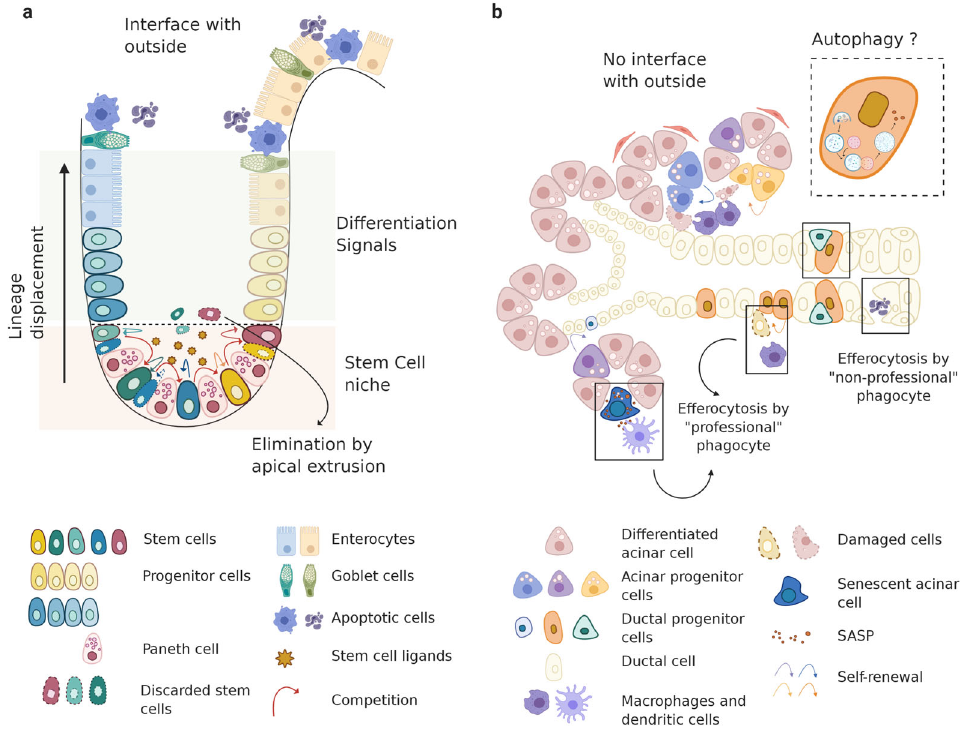
Fig. 3 Tissue anatomy and niche size determine the regenerative strategy adopted by different tissues. Adult stem cells in fast turnover epithelial tissues, such as the intestine ( a ), are subjected to neutral competition for limited stem cell-promoting factors and niche space. Only cells that have the capacity to receive stem cell-promoting factors will remain stem cells, the others will be eliminated by extrusion from the niche or via lineage displacement in the outer space. In a slow turnover tissue, such as the salivary gland ( b ), the high cellular density, as well as the branching structure, of the tissue could explain the absence of a “ professional ” stem-like cell and explain instead the presence of lineage-restricted progenitors. The absence of a direct opening for disposal of damaged/unwanted cells could force salivary glands to use alternative slower clearance routes, such as autophagy or tissue-resident immune cells (Figure created with